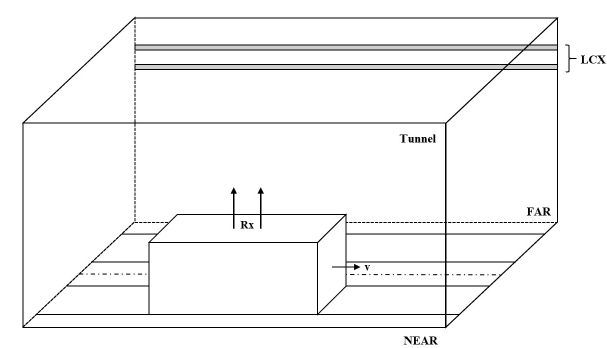
Figure 1. LCX channel in tunnel (LCXs on the far